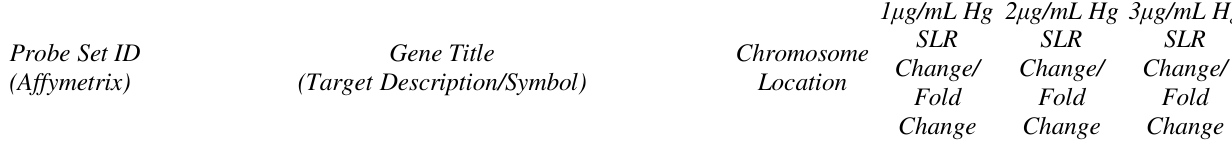
Table 1 contd.: Sample genes affected by mercury. Probe Set